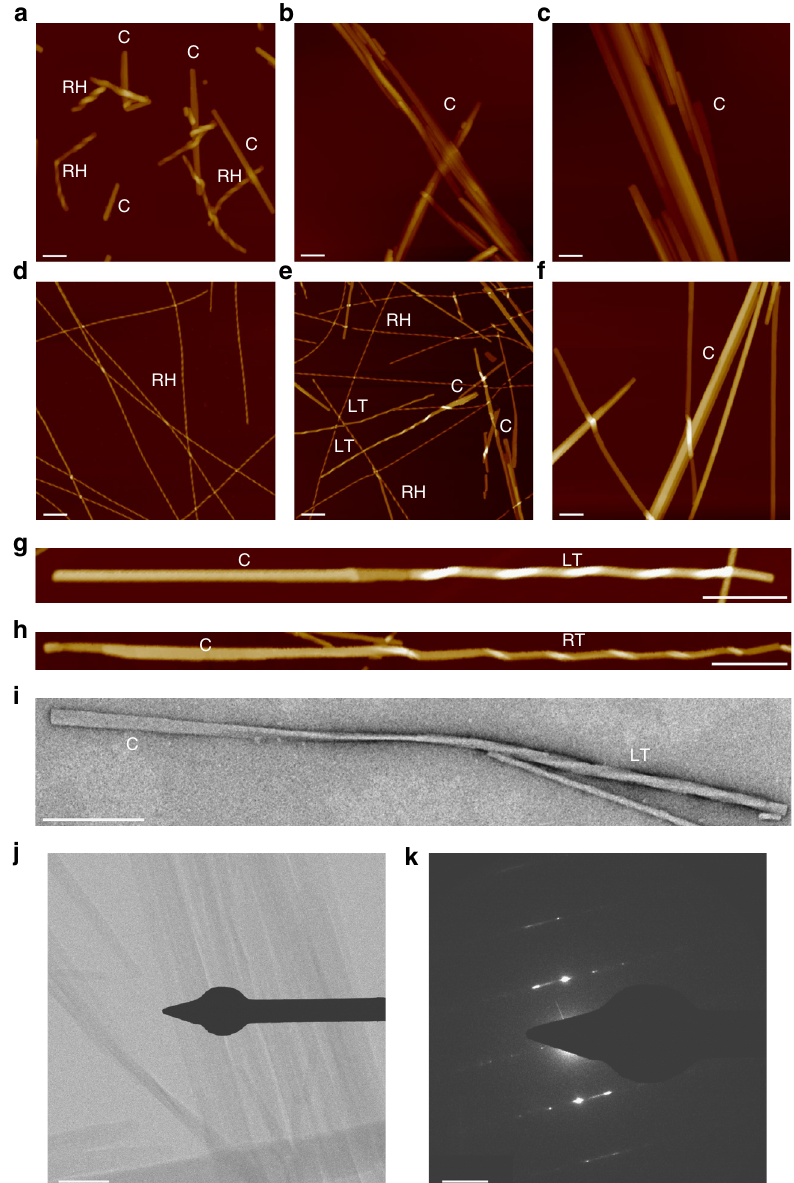
Fig. 1 AFM and TEM images of self-assembled structures formed by the three hexapeptides. a AFM images of ILQINS ( Z -scale = 100 nm), b IFQINS ( Z - scale = 100 nm) and c TFQINS ( Z -scale = 100 nm) at pH 2 and d ILQINS ( Z -scale = 30 nm), e IFQINS ( Z -scale = 30 nm) and f TFQINS ( Z -scale = 100 nm) at pH 7. AFM images g , h ( Z -scale = 20 nm) and TEM image (negatively stained) i of IFQINS at pH 7 showing fi bril-crystal conversion (scale bars = 200 nm). All structures formed at 1.5 mM peptide concentration after a 24 h incubation. RH = right-handed helical ribbon, LT = left-handed twisted ribbon, C = Crystal. j TEM images of TFQINS aggregates (scale bar = 200 nm) where k SAD was performed con fi rming the crystallinity of the TFQINS structures (scale bar = 20 nm − 1